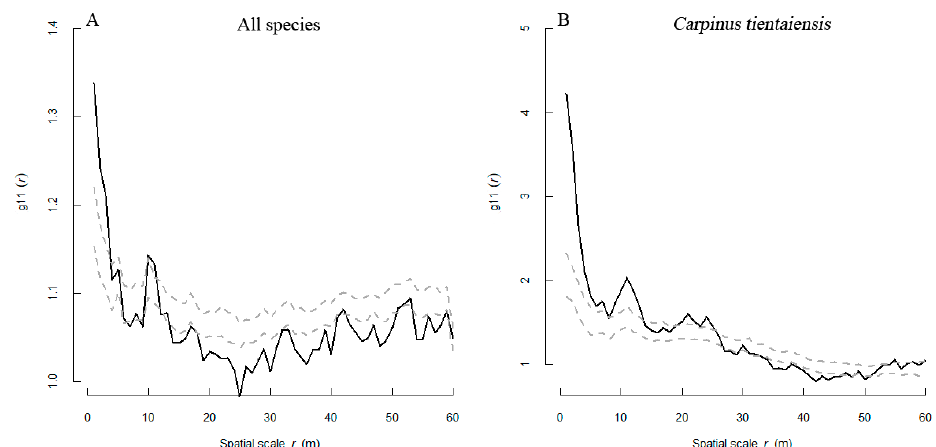
Figure 2. Spatial patterns of all species ( A ) and Carpinus tientaiensis ( B ) in the Carpinus tientaiensis sampling plot. Note: Black lines indicate the g 11 (r) function, dotted lines indicate the upper and lower limits of the 99% confidence interval. Observed values above the upper limits indicate aggregation, within the intervals indicate random distributions, and below the lower limits indicate a regular/hyperdispersed pattern.